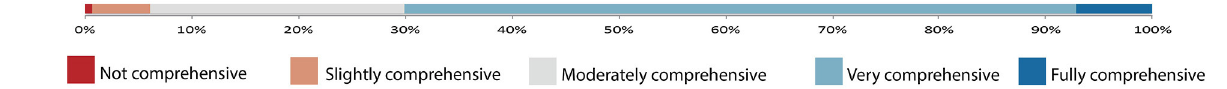
“social/cultural endorsement.” Calculating Cohen’s d on such for educational research ( d > 0.4) (Hattie, 2008) meaning that